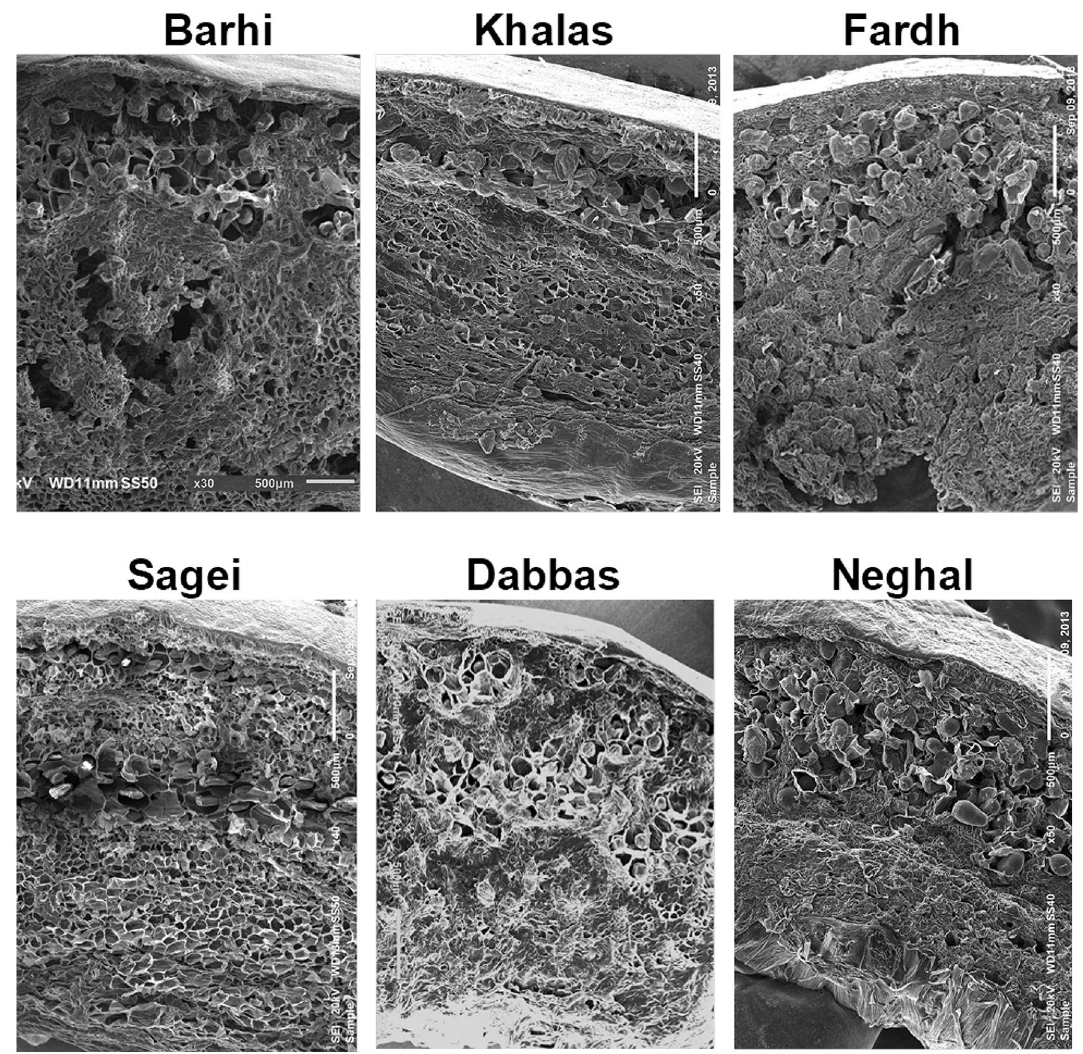
Figure 3. Variability of the microstructure of selected date